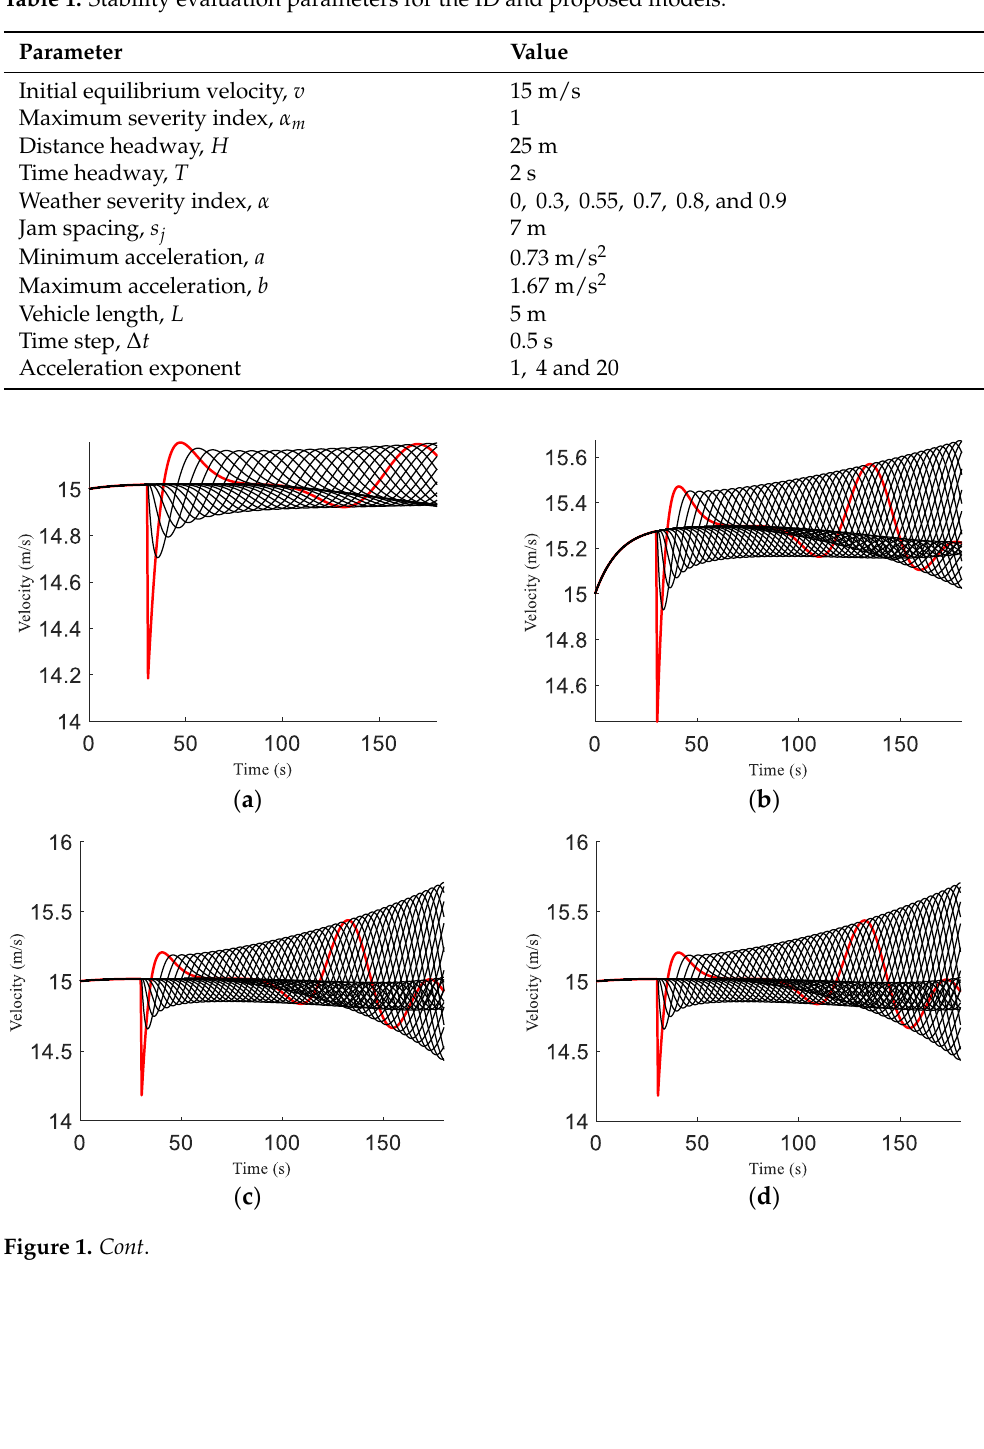
Table 1. Stability evaluation parameters for the ID and proposed models.